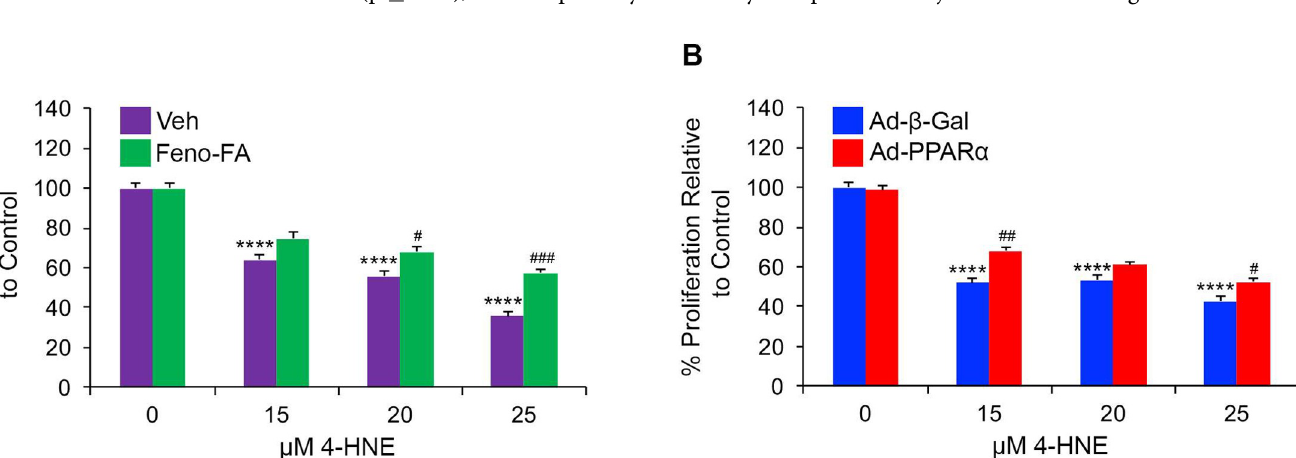
Fig 3. In vitro neuroprotective effects of PPAR α activation and overexpression. (A) MTT assay revealed that cell viability declined in R28 cells treated with the indicated concentrations of 4-Hydroxynonenal (4-HNE) for 24 hours, and was partially restored by treatment with 25 μ M fenofibric acid (Feno-FA) relative to vehicle (Veh, DMSO) (n = 6 wells/group). (B) MTT assay revealed that cell viability declined in 4-HNE-treated R28 cells, and was partially restored by infection with PPAR α - expressing adenovirus (Ad-PPAR α , MOI 20) relative to infection with Beta-galactosidase-expressing adenovirus (Ad- β -Gal) (n = 6 wells/group). Data are representative of two independent experiments, and are expressed as mean ± SEM. ���� p � 0.0001 relative to (A) Veh or (B) Ad- β -Gal-treated 0 μ M HNE groups. #p � 0.05, ##p � 0.01, ###p � 0.001 relative to cells treated with an equal concentration of HNE and (A) Veh or (B) Ad- β -Gal. One-way ANOVA with Tukey’s post-hoc